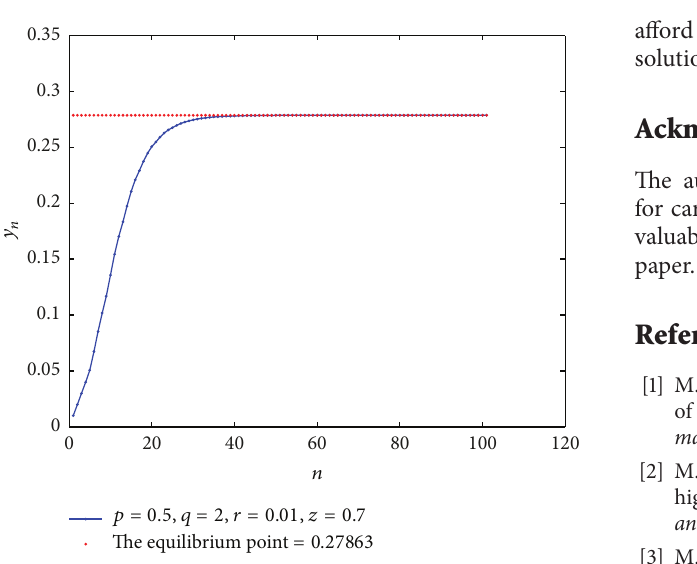
Figure 2: Dynamics of 𝑦 𝑛+1 = (0.01+0.5𝑦 𝑛 +𝑦 𝑛−3 )/(0.7+2𝑦 𝑛 +𝑦 𝑛−3 ) .